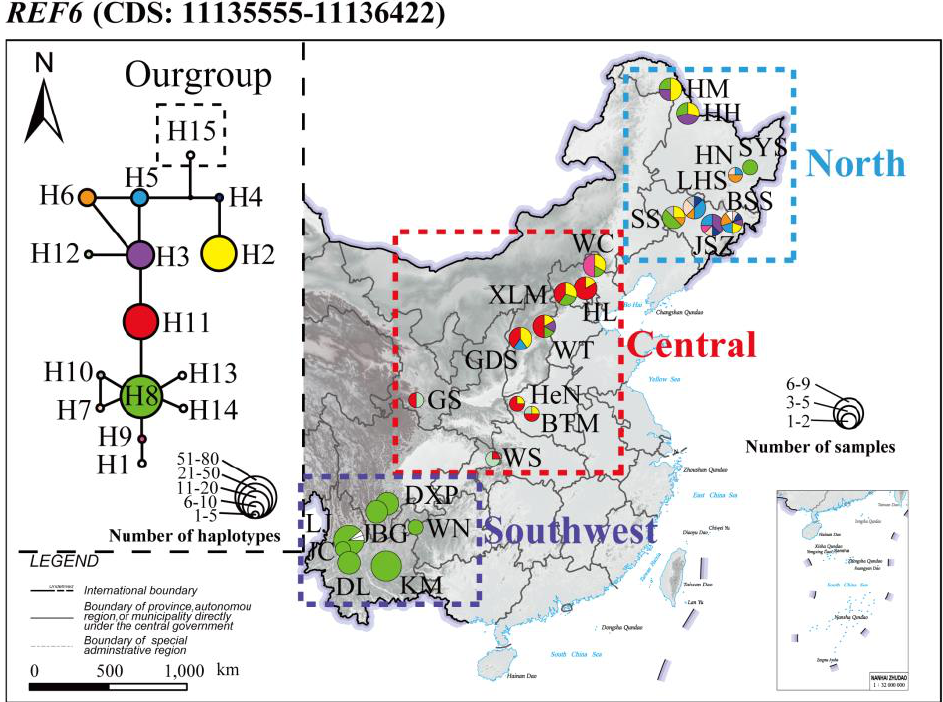
Figure 5. Frequencies and relation of DNA haplotypes of the REF6 gene across the population range of P. davidiana . One CDS region of REF6 (11135555–11136422) was selected as the representative haplotype network, and the distribution of haplotypes was marked on a relief map of China. Colored haplotypes are shared by two or more populations of sampling locations, and private haplotypes are not colored. The outgroup is framed in a square. The sizes of circles in the network are proportional to the observed number of individuals in the haplotypes, and the sizes of the circles on the map are proportional to the population sizes of sampling locations.